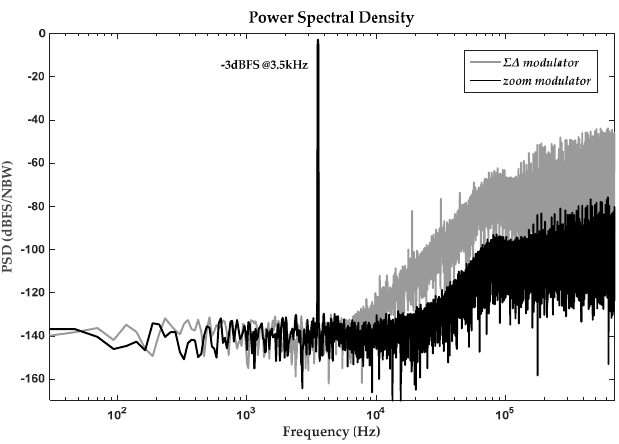
Figure 11. PSD comparison of ΣΔ and zoom modulator.